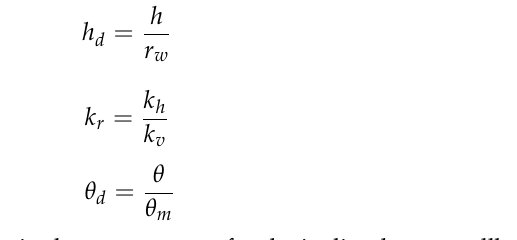
Table 2. The ranges of the three dimensionless parameters. Dimensions and Properties of the Sample Values (Units) Ratio of reservoir thickness to wellbore radius ( h d ) 80–540 Range of permeability ratio ( k r ) 1–10 Range angle of the slant ( θ ) 10 ◦ –75 ◦